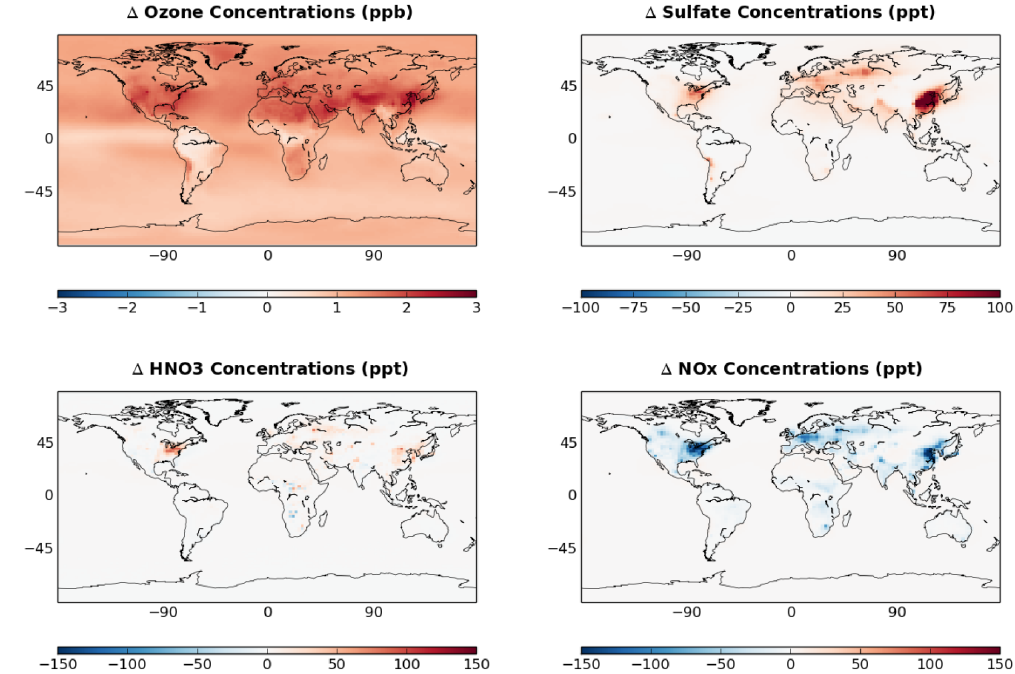
Figure 5. Difference in mean ozone, sulfate, nitric acid and NO x mixing ratios mixing ratios between the HNO 3 and base case simulations for the surface layer. The simulation period spanned an entire